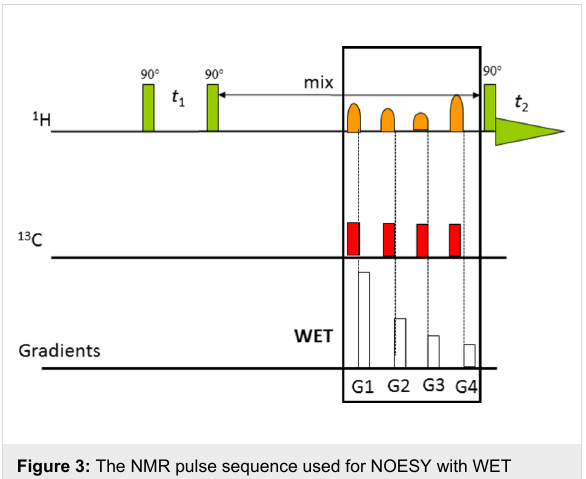
Figure 3: The NMR pulse sequence used for NOESY with WET solvent suppression